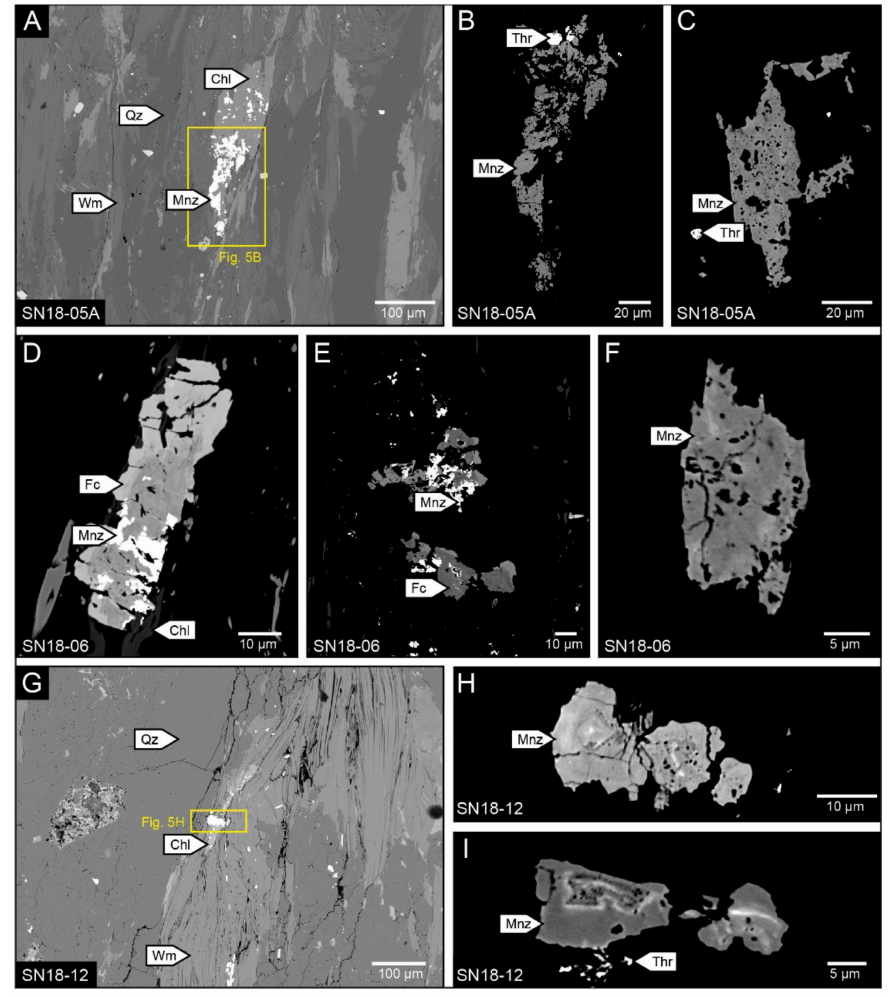
Figure 5. Back-scattered electron images of monazite showing representative textures and relations with other minerals. ( A – C ) Depictions of monazite for sample SN18-05A. Monazite is typically found as ‘archipelagos’ of irregularly shaped monazite in close spatial association with chlorite that is aligned with the foliation. Internally, the monazite exhibits a very porous texture. ( D – F ) Monazite of sample SN18-06 nucleating on grains of florencite. These grains are also associated with chlorite and show porous internal textures. ( G – I ) Monazite from sample SN18-12. These monazite grains are closely linked with chlorite in the main foliation and sometimes show textural zoning with porous cores surrounded by non-porous rims. No distinction in dates were obtained between the textural cores and rims. Abbreviations: Chl, chlorite; Fc, florencite; Mnz, monazite; Qz, quartz; Wm, white